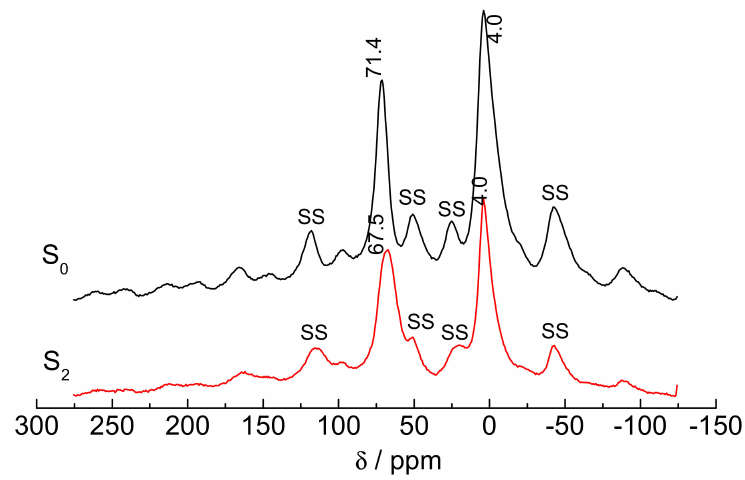
Figure 6. 27 Al NMR spectrums of S 0 and S 2 (SS means “spinning